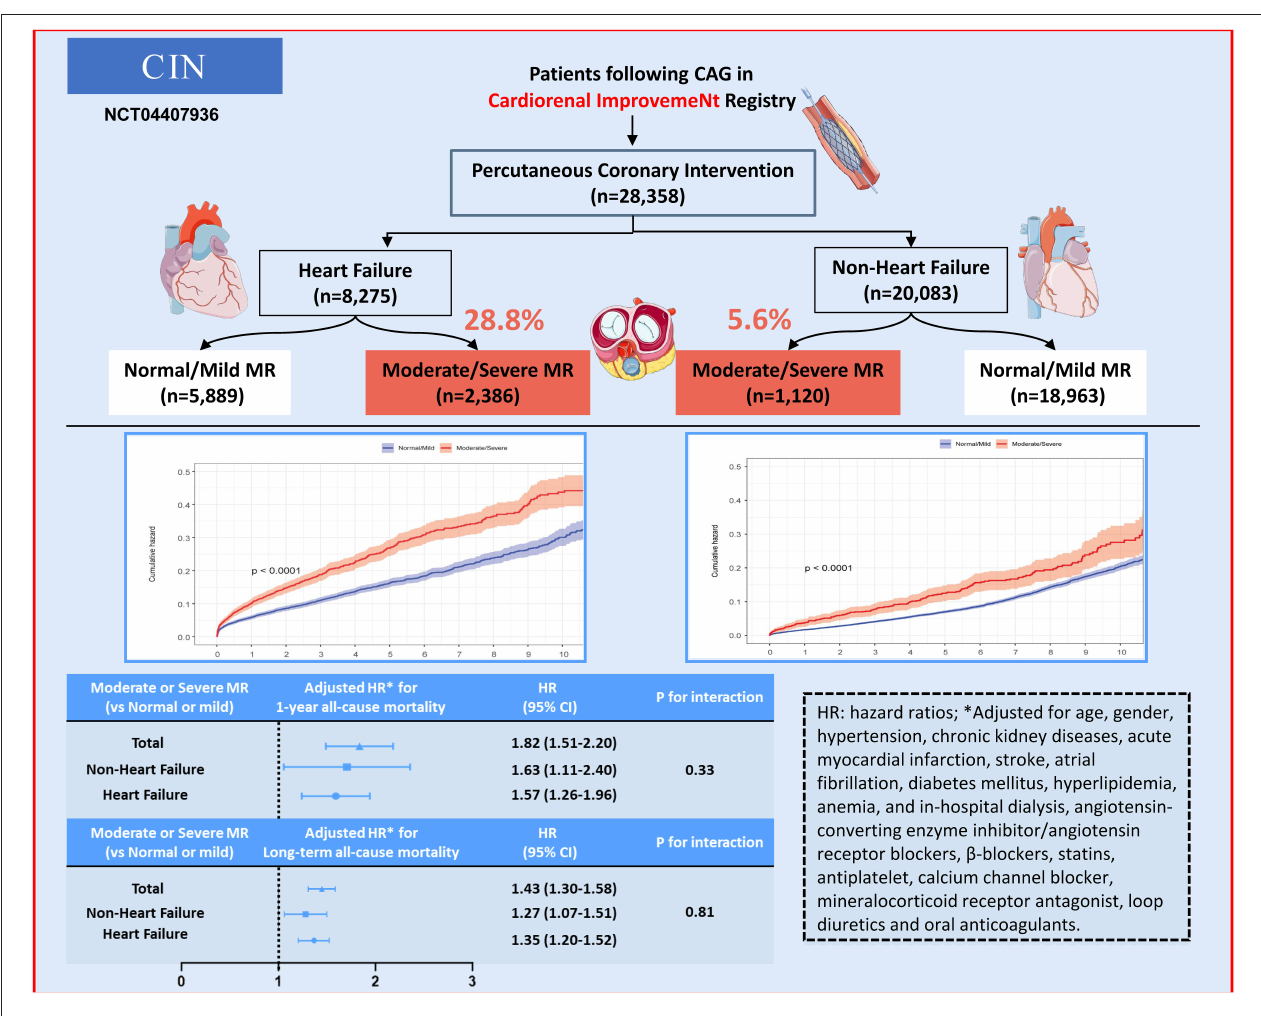
FIGURE 4 | Central